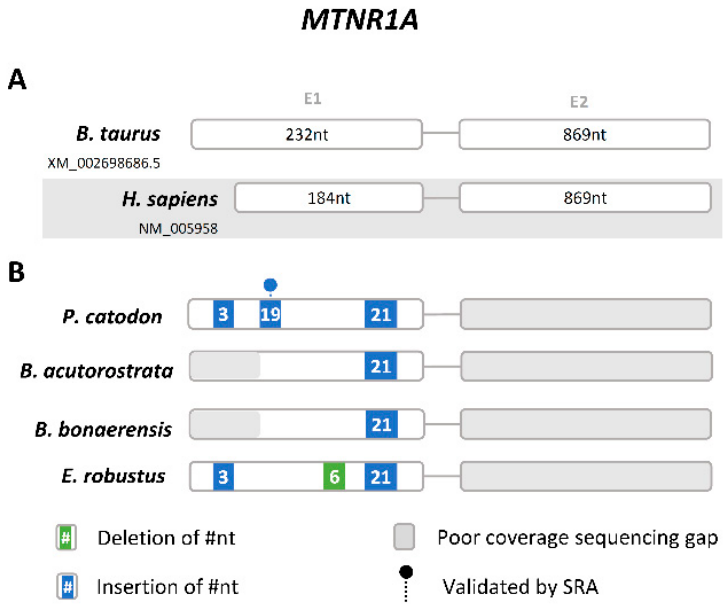
Figure 4. Gene annotation of Mtnr1a relics in Mysticeti. ( A ) Schematic representation of the gene structure of human and B. taurus Mtnr1a gene (not to scale), each box represents an exon and lines represent intronic region. ( B ) Schematic representation of the corresponding Mtnr1a genes identified in Cetacea and location of the identified insertions and deletions.